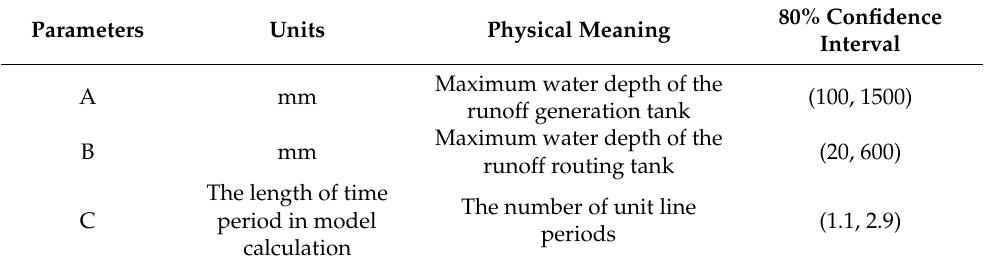
Table 1. GR3 model parameters needed to be calibrated.